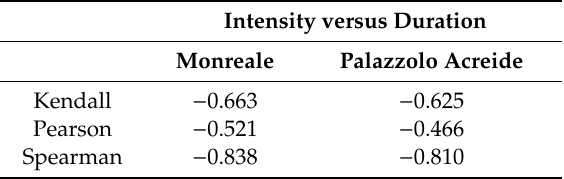
Table 2. Estimated values of different measures of correlation between rainfall variables.